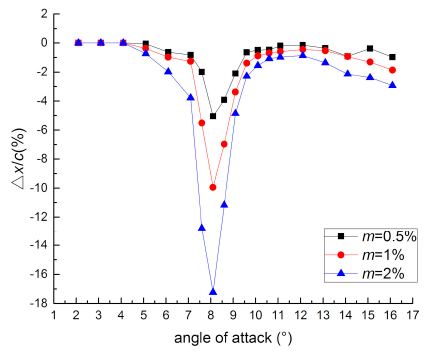
Figure 11. Particle concentration effects on moving distance of separation point on S809 airfoil at Re = 1 × 10 6 .